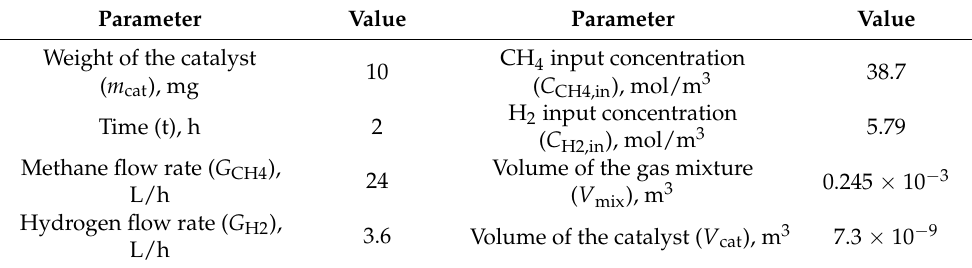
Table 2. The input parameters of the mathematical